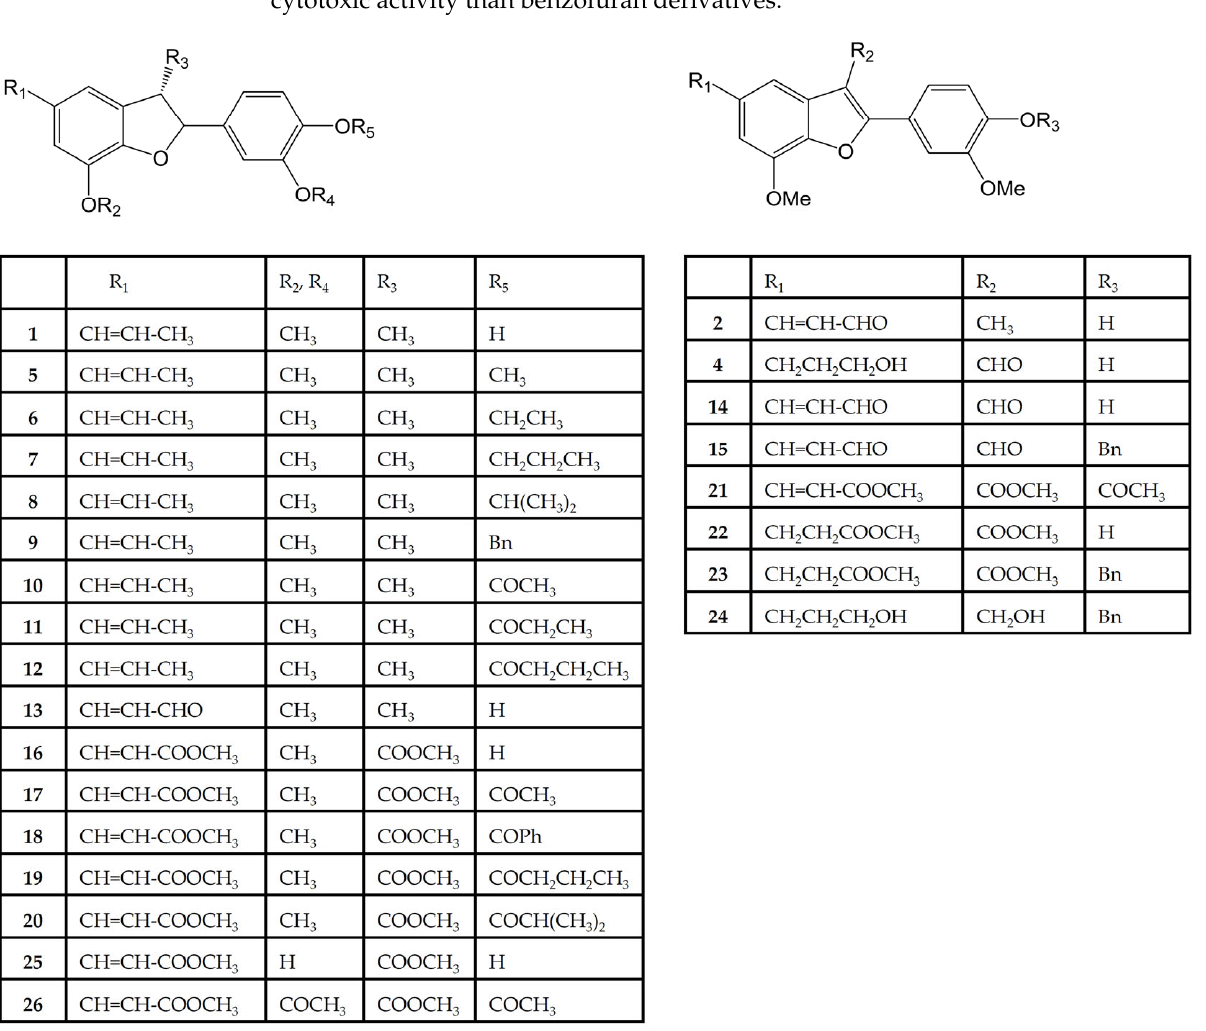
Figure 1. Structures of benzofuran and dihydrobenzofuran salvinal derivatives.